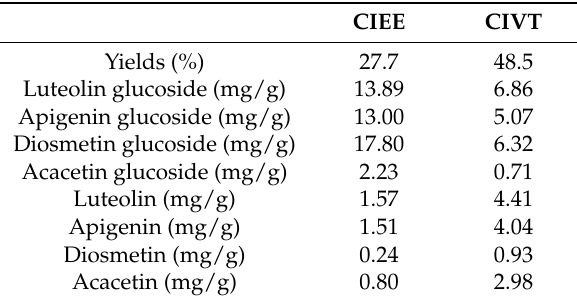
Table 3. Comparison of the main components from CIEE and